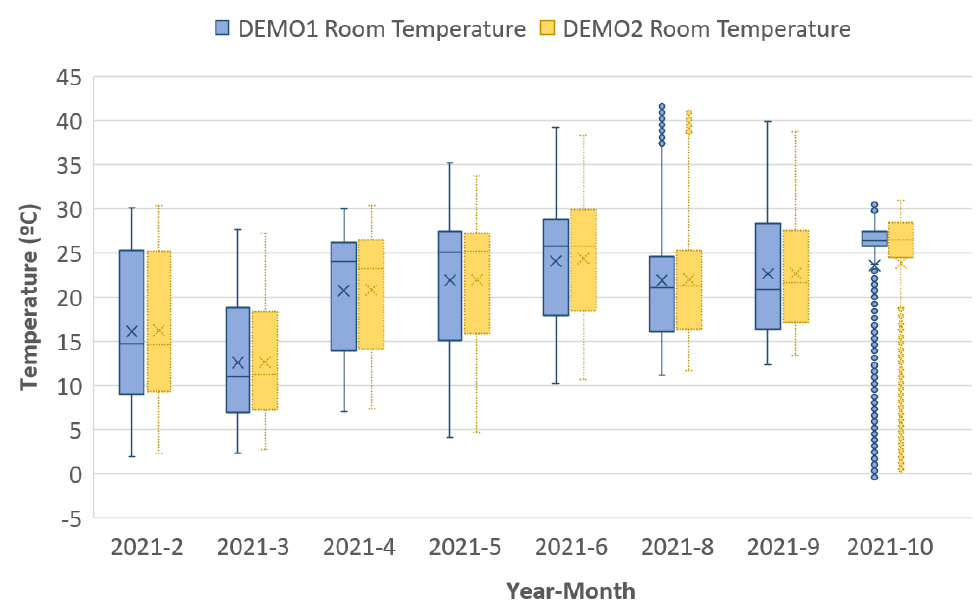
Figure 7. Statistical analysis per month for the comparison of indoor room temperature values monitored at DEMO1 (reference) and DEMO2 (test cell) during free-floating temperature mode periods with indoor coating elements based on Micronal ® DS 5001X.